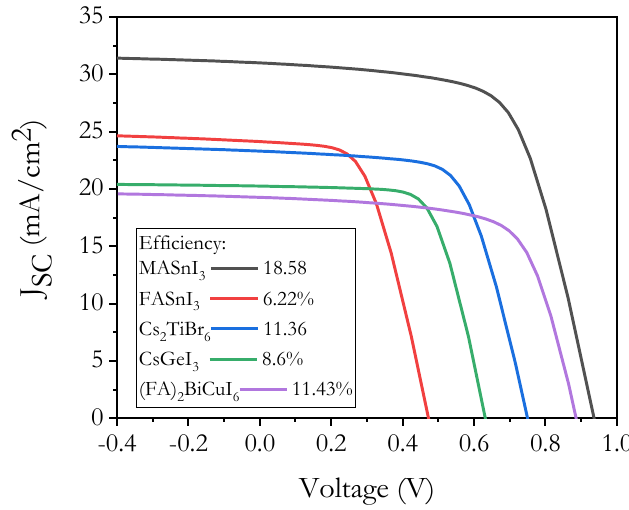
Figure 2. J−V characteristics of lead-free n-i-p PSCs . Figure 2. J − V characteristics of lead-free n-i-p PSCs